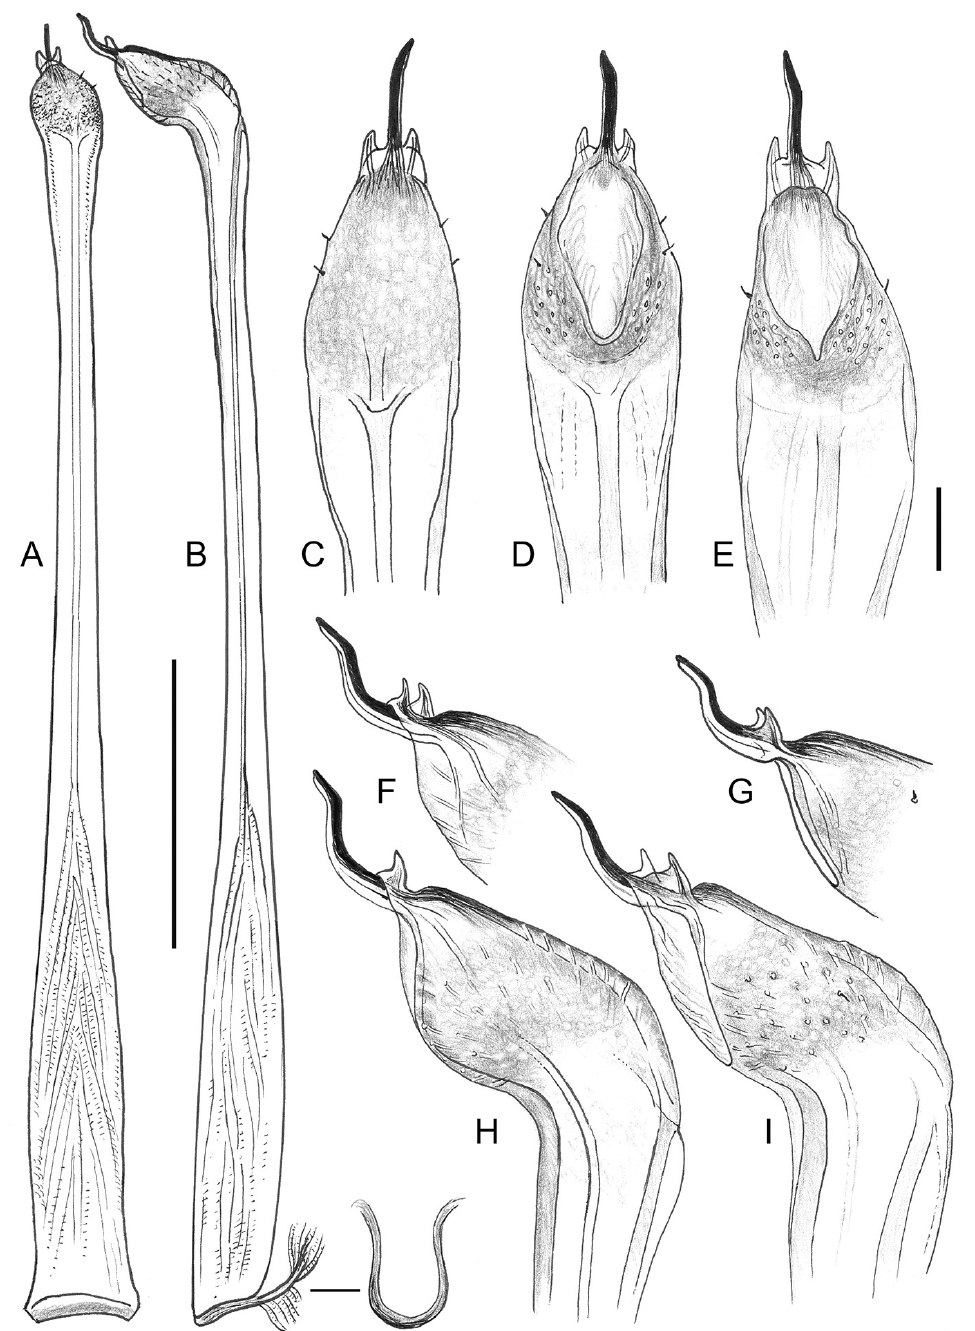
Fig. 8. Dicranopalpus insignipalpis (Simon, 1879) . Penis. A . Ventral view. B . Lateral view, with frontal view of torn off basal portion of extrinsic penial muscle tendon. C . Ventral view of glans. D – E . Dorsal view of glans. F . Ventrolateral view of glans. G , H . Lateral view of glans. I . Dorsolateral view of glans. A–D, F, H. (CHW 474); E, G, I. (CJM 7258). Scale bars: A–B = 0.5 mm; C–I = 50